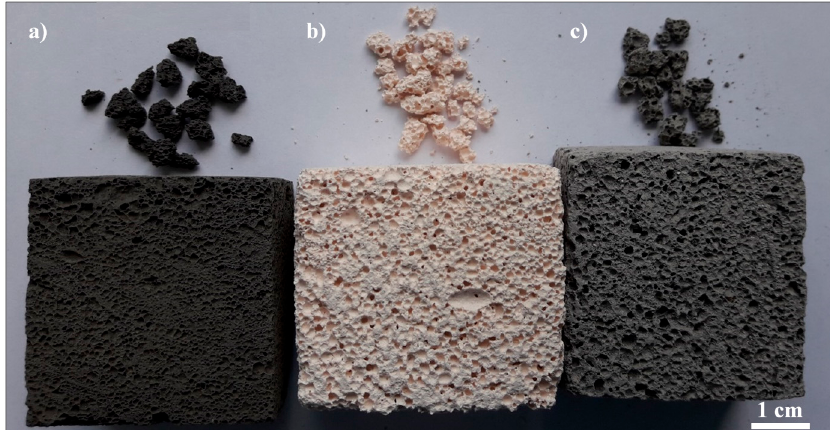
Figure 2. Porous structure of obtained monolithic pAAM and prepared pAAM granules for leaching test: ( a ) FA_0, ( b ) MK_0, ( c ) FA + MK_0.